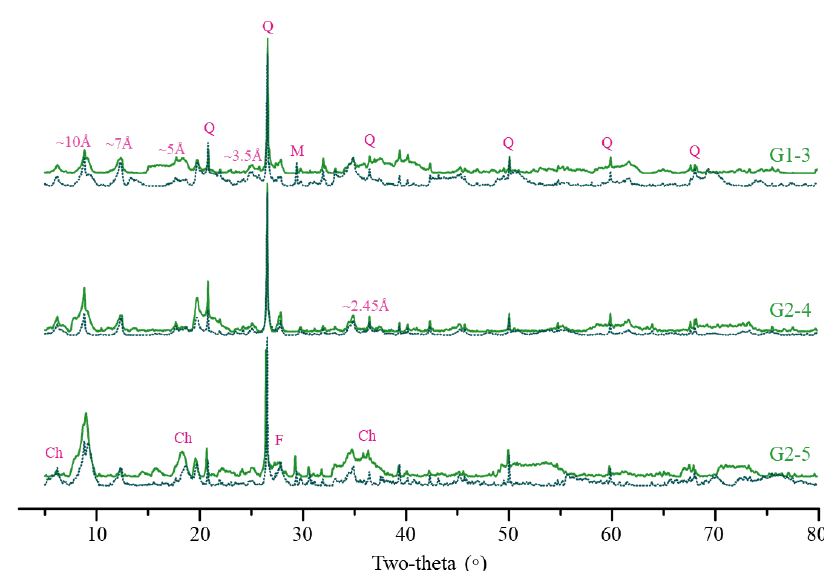
Figure 6. XRD patterns of residual samples after acid leaching. All residual samples were analyzed after drying at 40 °C (solid patterns) and 105 °C (dashed patterns) causing the differences in the diffraction pattern. Other minerals, such as quartz (Q), feldspar (F), chlorite (Ch) and muscovite (M), were labeled near the pattern. Peaks at ~10 Å and ~5 Å are characteristic for 10 Å Mn phases (todorokite/10 Å vernadite). The peaks around ~7 Å are corresponding to 7 Å vernadite. After heating treatment (105 °C/24 h), peaks around ~10 and ~5 Å which are still present but with lower intensity, which are characteristic of stable todorokite phases.